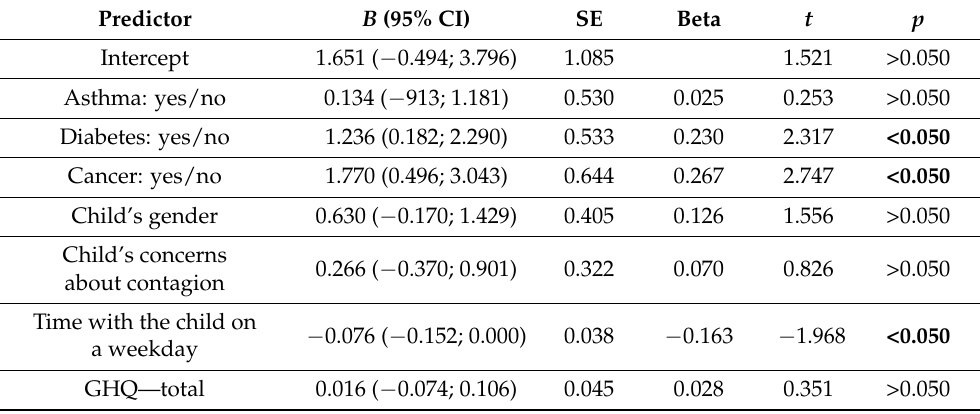
Table 4. Linear regression model of children’s internalizing symptoms. Bold for p -values < 0.050. B , unstandardized beta; SE, standard error; Beta, standardized beta; t, the t -value (the coefficient divided by its standard error); 95% CI, confidence intervals; Adj. R 2 , adjusted R-squared.